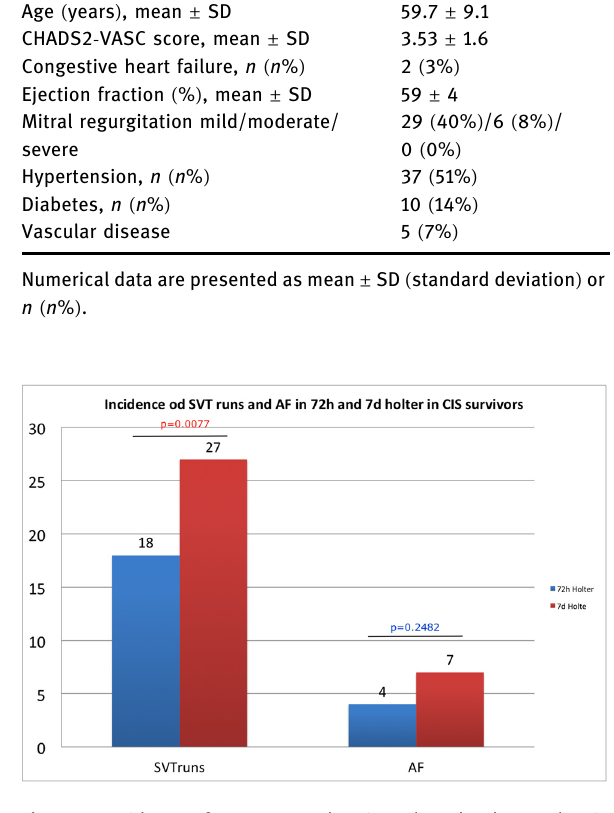
Figure 1: Incidence of SVT runs and AF in 72 h and 7 days Holter in cerebral ischemic stroke